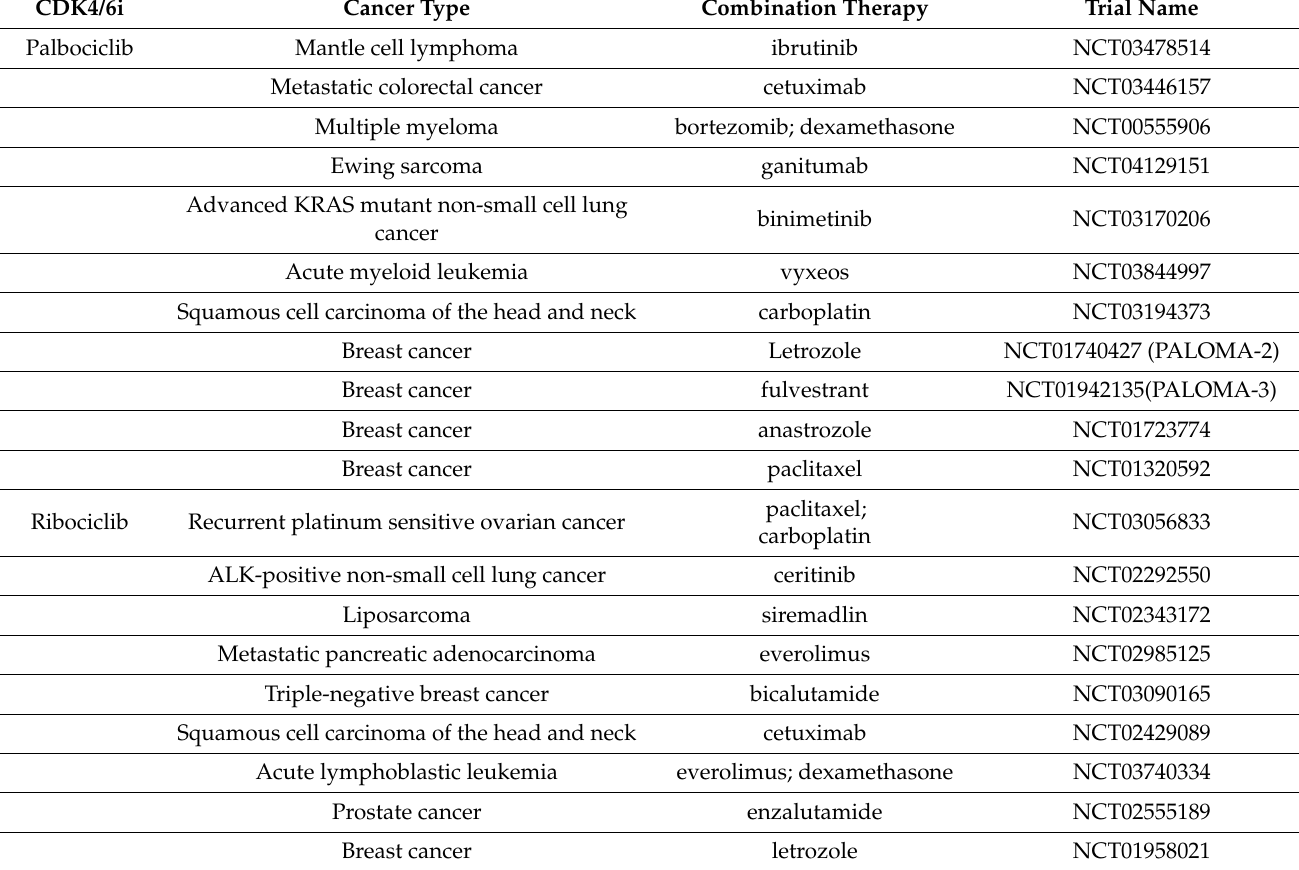
Table 2. Representative clinical trials using CDK4/6i in combination